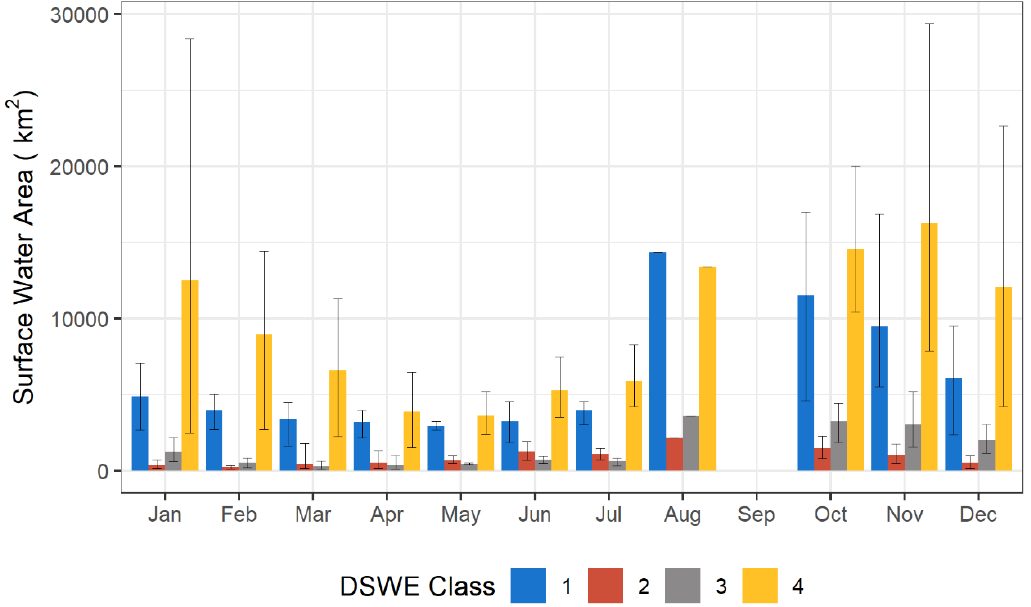
Figure 3. Monthly mean surface water area (1988–2018) across Cambodia in each of the DSWE water classes: (1) high confidence, (2) moderate confidence, (3) partial or vegetated class, and (4) water or wetland—low confidence. Whiskers denote minimum and maximum extents. There was a single clear scene ( < 20% cloud cover over the entire country) in August across the time period; there were no clear scenes in September.